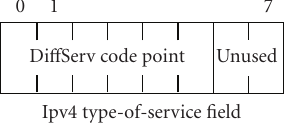
Figure 1: TOS field